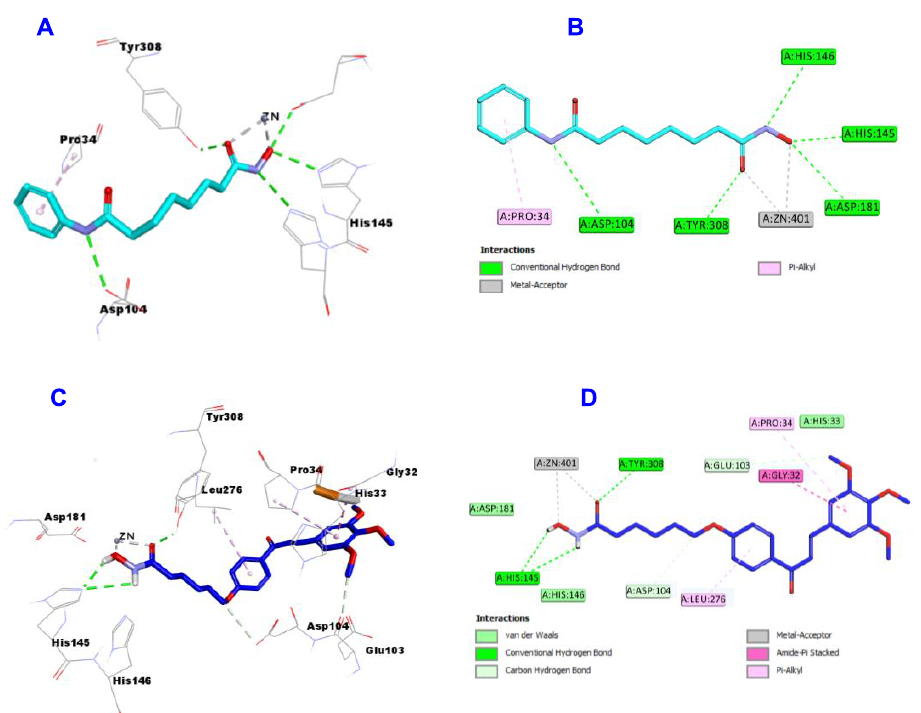
Figure 8. Docking and binding mode of SAHA (cyan) and 4b (blue) into the active site of HDAC2 (PDB: 4LXZ); ( A ) 3D structure of SAHA , ( B ) 2D structure of SAHA , ( C ) 3D structure of 4b , ( D ) 2D structure of 4b .